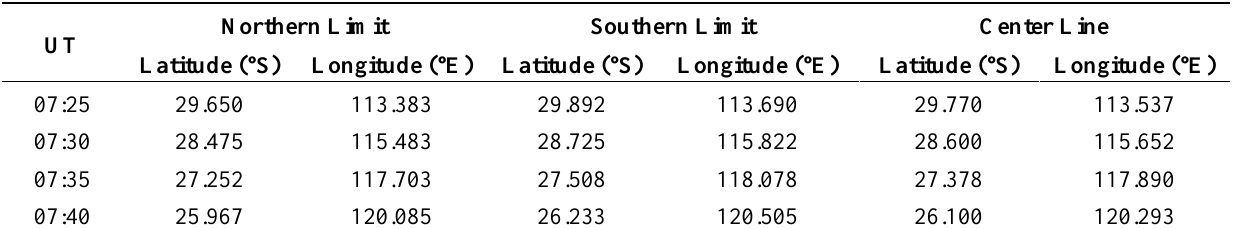
Table 1. The center, northern and southern limits of the solar eclipse path between 07:25 UT and 07:40 UT on February 16,